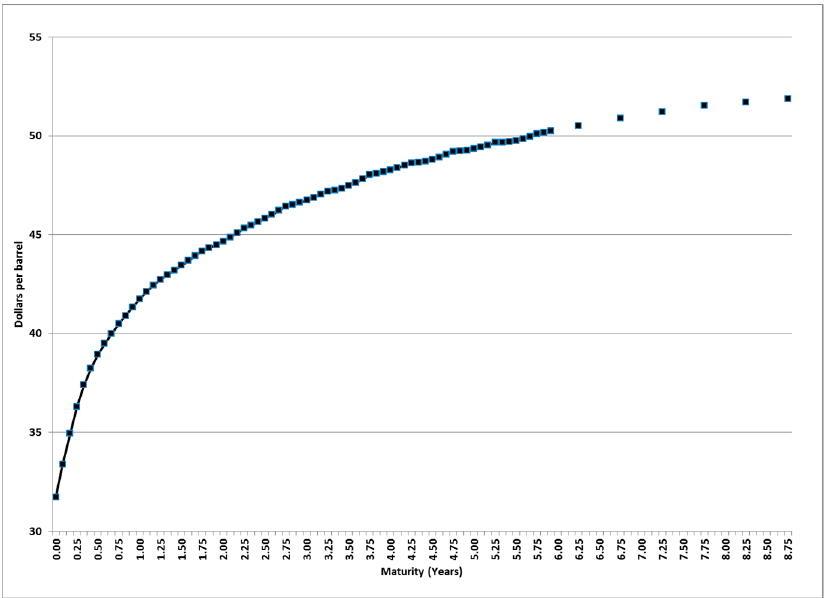
Figure 1. WTI Futures Prices term structure (2 April 2016). Source: our own calculations with ICE Futures Prices.